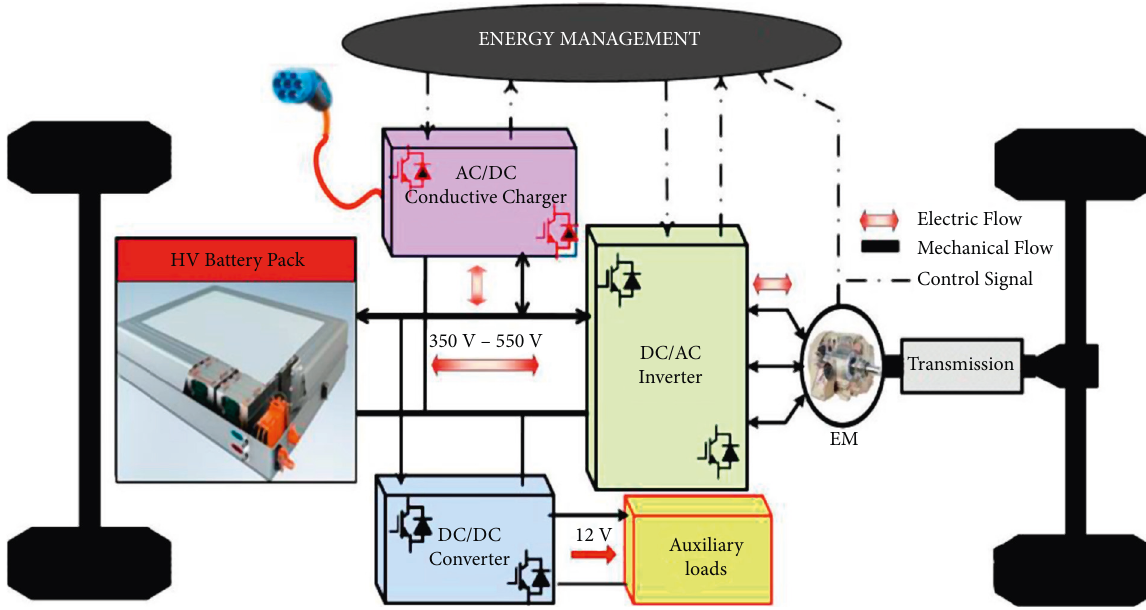
Figure 1: Electric vehicle components and its charging